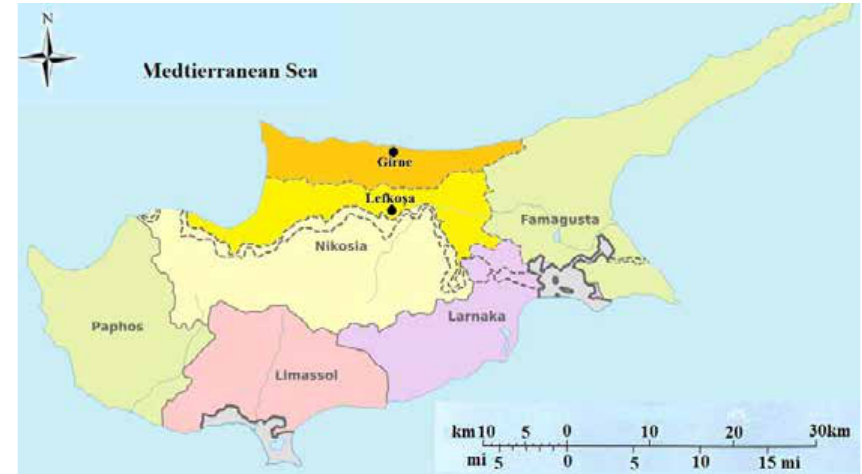
Fig. 2: The geographic location of the study area in Cyprus